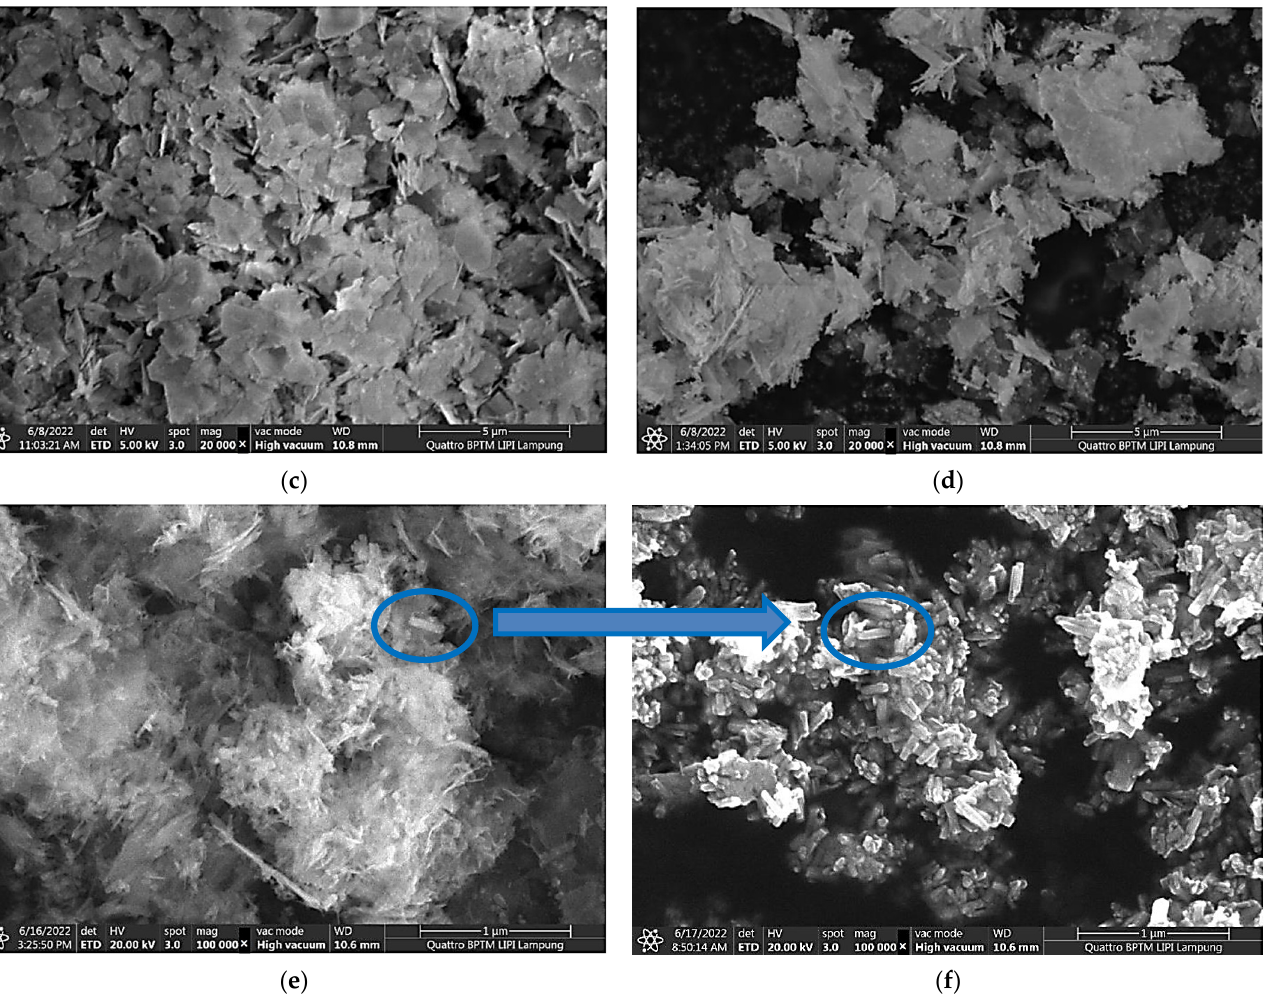
Figure 3. Morphology (FESEM image) of the particle formed in the in situ synthesis of ZnO NPs on ND-colored Batik fabrics at ( a ) pH 6, ( b ) pH 7, ( c ) pH 8, ( d ) pH 9, ( e ) pH 10, ( f ) pH 11.